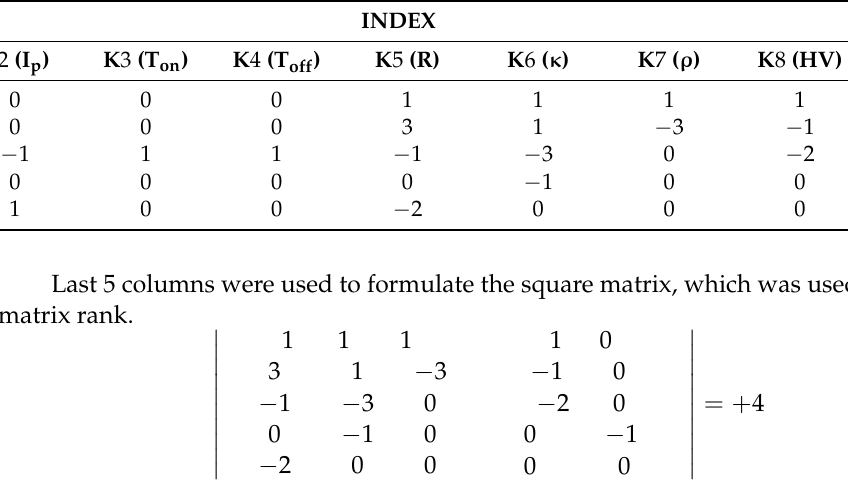
Table 6. Parameter